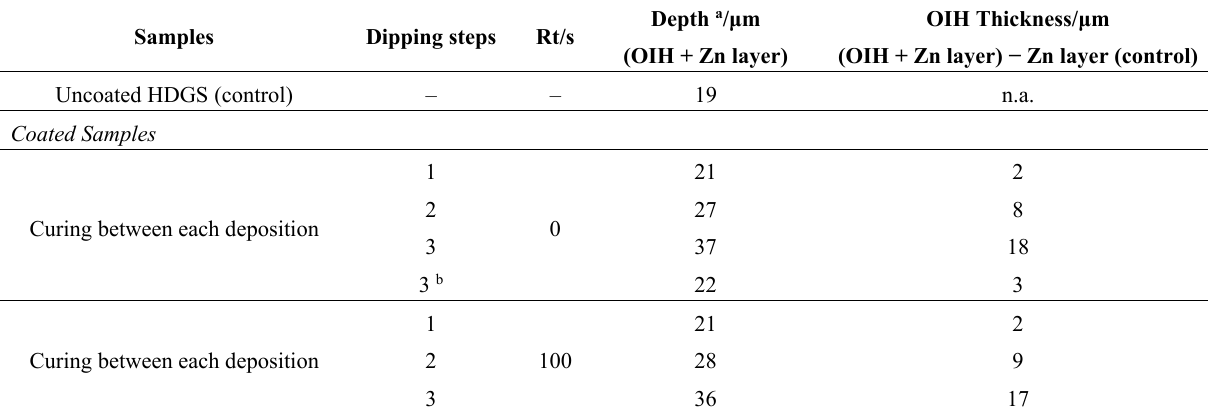
Figure 1. Detailed view of the GD-OES depth profiles for Zn, C, Fe and Si within HDGS substrates for ( a ) control; ( b ) one layer of U(400) and Rt = 0 s; ( c ) three layers of U(400) with cures between each deposition and Rt = 0 s; ( d ) three layers of U(400) with cures between each deposition and Rt = 100 s. Table 2. Depth of OIH and zinc layer and thicknesses obtained for every condition